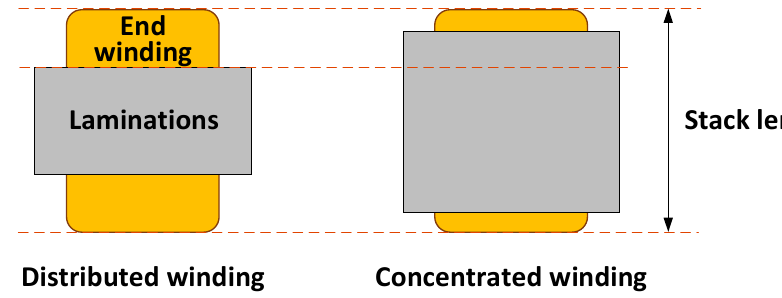
Figure 14. Demonstration of the end winding of the 12/4 SynRMs.